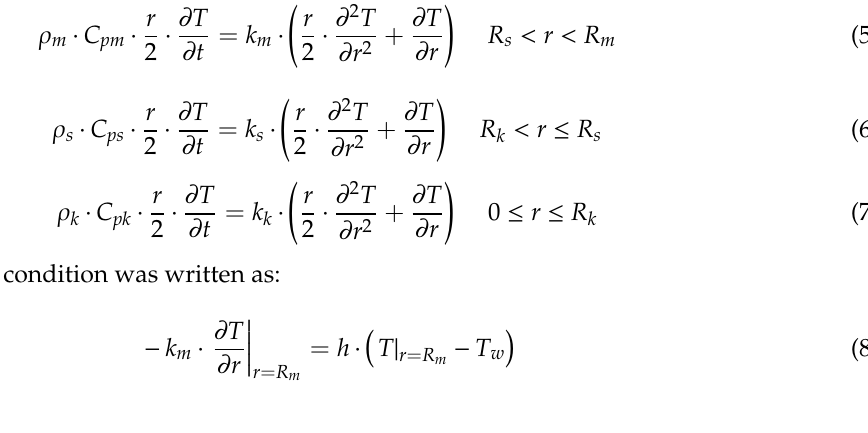
Table 1. Density and thermal properties of